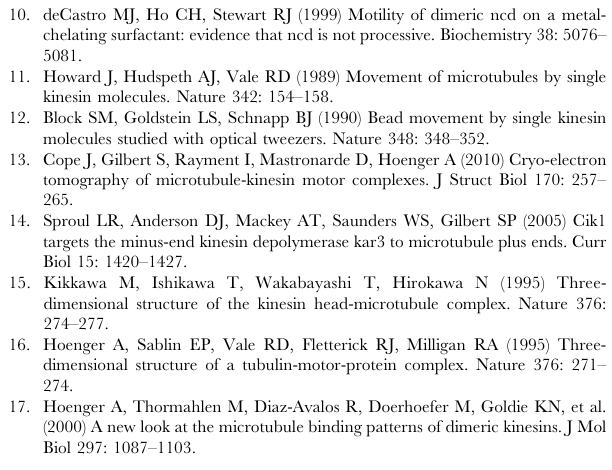
Figure S4 Fourier Shell Correlation curves provide an estimate of resolution of the helical reconstruction data. The total data included in each final helical reconstruction was divided in half. Individual reconstructions were made from each of the half datasets and these two reconstructions were correlated against each other over a range of spatial frequencies. Using a correlation score of 0.5 as a criterion for estimating the resolution of the data, the helical averages presented in this paper have resolutions ranging from 2.2–2.5 nm. Fourier Shell Correlation curves were calculated and plotted using PEET. (TIF)